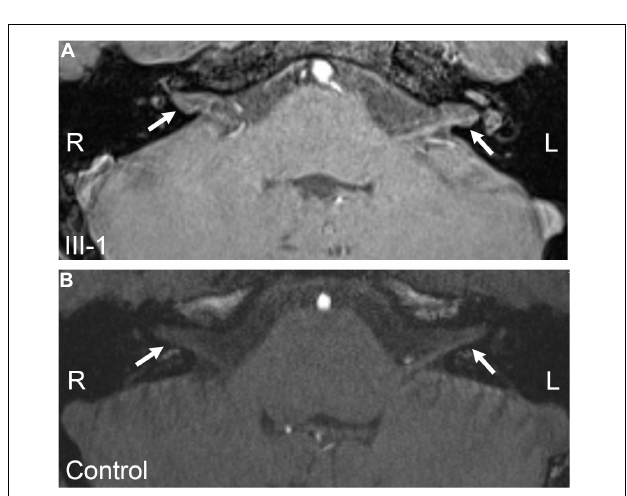
FIGURE 4 | MIP images of MRI for III-1 following intravenous gadolinium (Gd) injection. (A) Image of the right ear. (B) Image of the left ear. The red dotted circle: showed distensible sacculus in the vestibular pool. R, right ear; L, left ear.